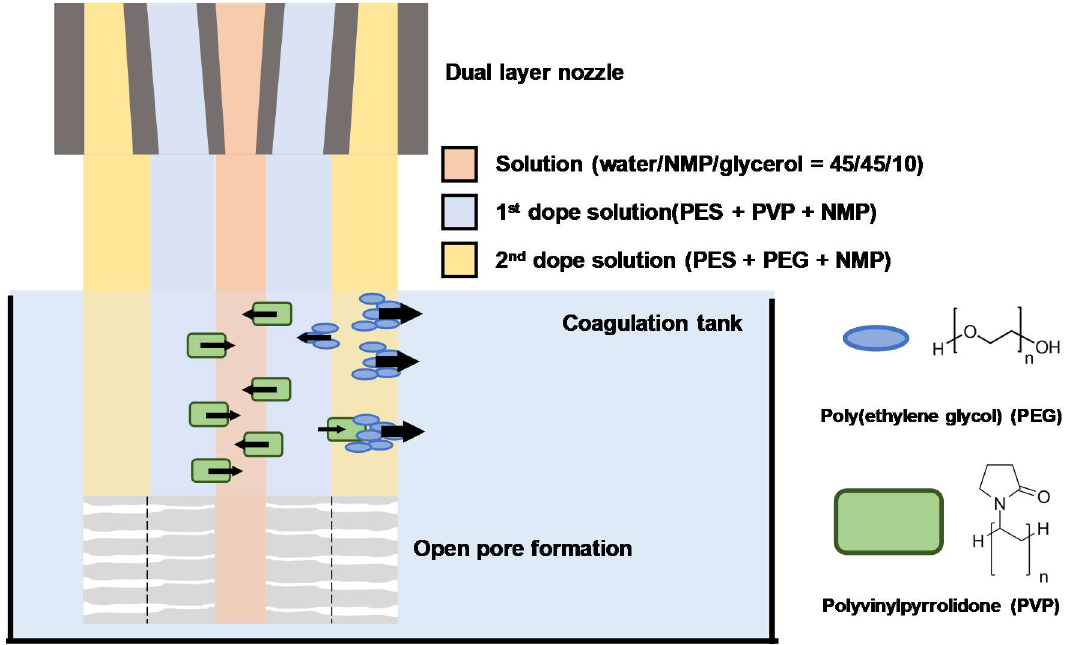
Figure 2. The schematic diagram of dual-layer spinning of dual-pore former that includes dual-phase dope solution via dual-layer nozzle . Table 3. Intrinsic properties of components in dope solution and non-solvent .